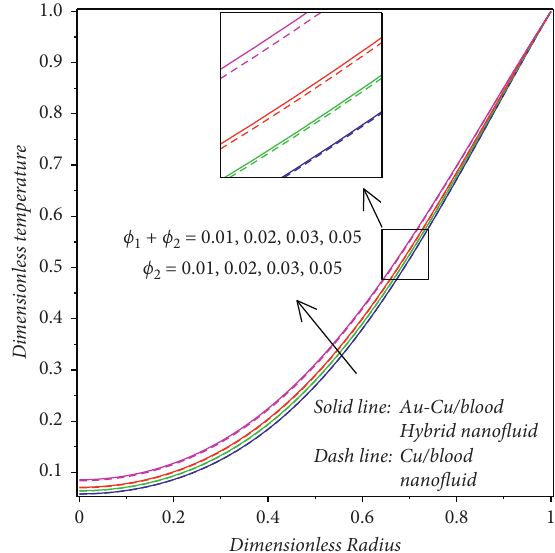
Figure 7: Behaviour of ϕ